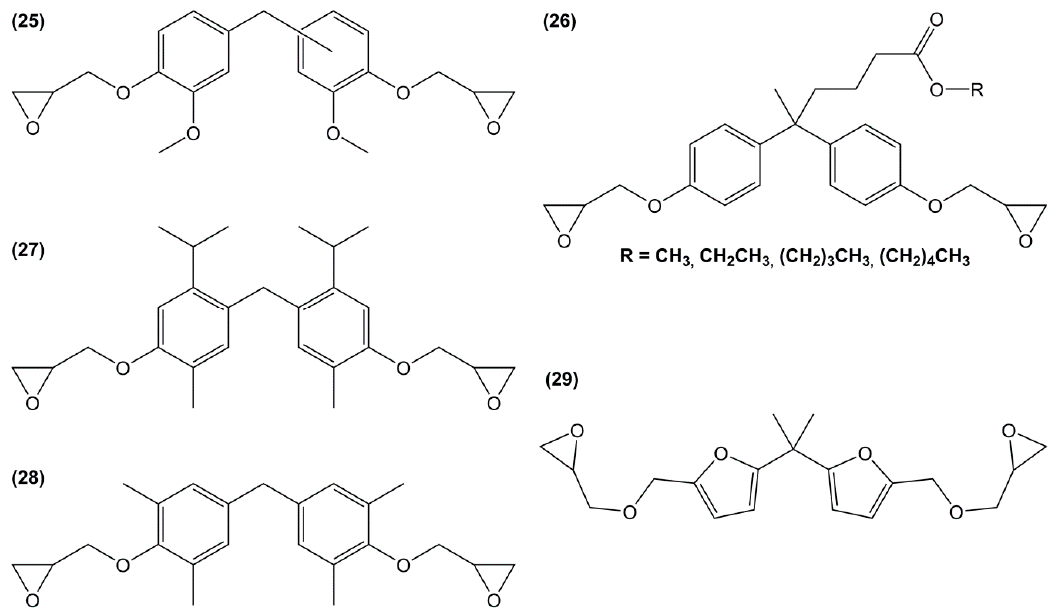
Figure 19. Bio-based di-aromatic epoxy derivatives with a single carbon atom spacer.